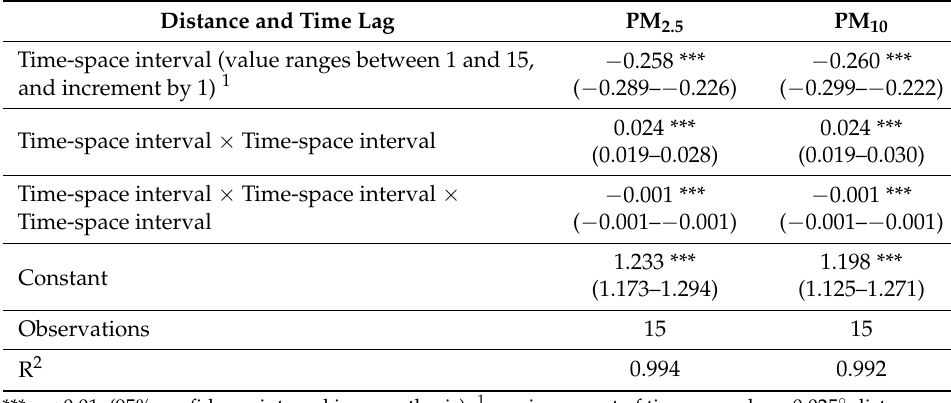
Table 2. Polynomial trend of autocorrelation with respect time-space intervals. Distance and Time Lag